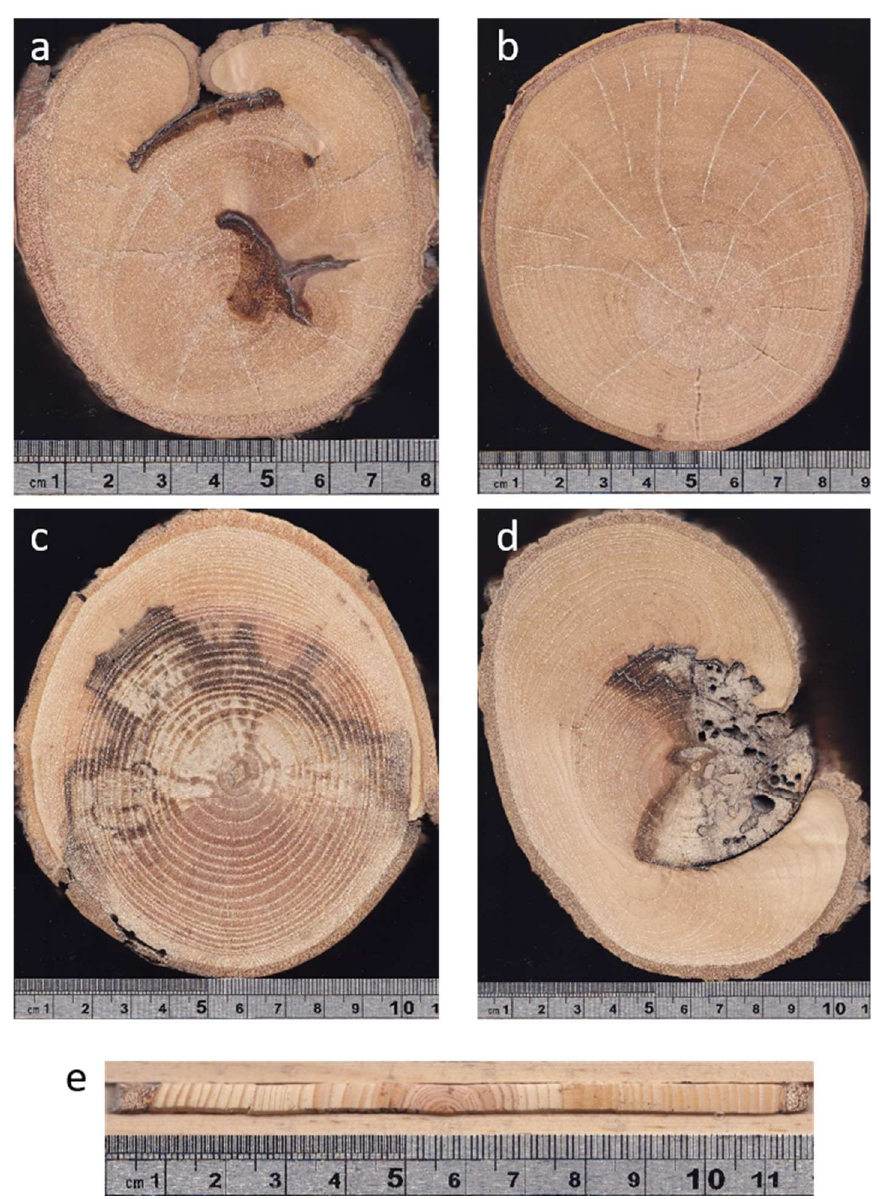
Figure 5. Stem cross-sections and core of: ( a ) Tilted birch showing scars of two injuries in winters 1971–72 (close to the center) and 1995–96 (more external) (tree 8); ( b ) leaning birch showing eccentrical growth after winter 1995–96. First tree rings in the center are round (upright period of the stem) and become elliptical after this winter. At the same time, tension wood is produced on the upper side of the stem (slightly darker color of the wood on this species) (tree 9); ( c ) horizontal ash tree, knocked down in winter 1995–96. During the first 20 years the tree was growing upright (concentric rings from 1978 to 1995). In the next 20 years, from 1996 to 2015, tree rings develop eccentrically and growth rate is slowed down (growth suppression) (tree 17); ( d ) ash tree bearing a lateral scar from an injury in winter 1995–96. Thereafter, there is a gradual overgrowth to close the gap year after year. The wood is decaying (dark wood) as a consequence of the injury (tree 19); ( e ) transversal increment core of the curved stem of a mountain pine showing GD occurred in winters 1977–78 and 1995–96. Due to the flexibility of the young stem, it recovered the vertical position after 1978. It was tilted again in 1996 and a permanent curvature started. At the same time, compression-wood rings (brown) develop on the downslope side (right) and narrow rings on the upslope side (tree